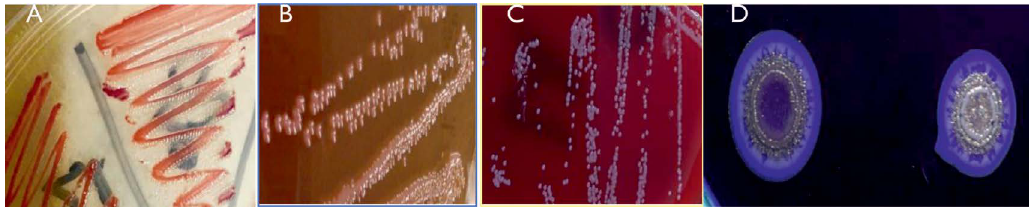
Fig. 1. Colony of Acinetobacter baumanii . A: On Chromo agar; B: OnMacConckey aga; C: On Blood agar r; D: On Modified Media